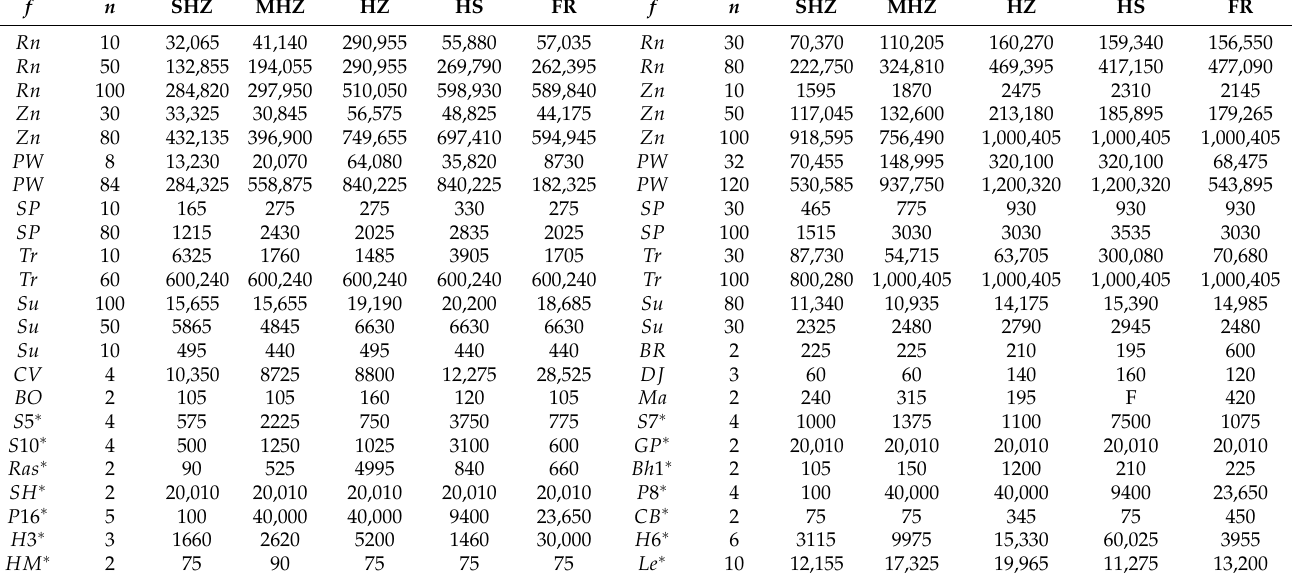
Table 3. The number of worst function evaluations.